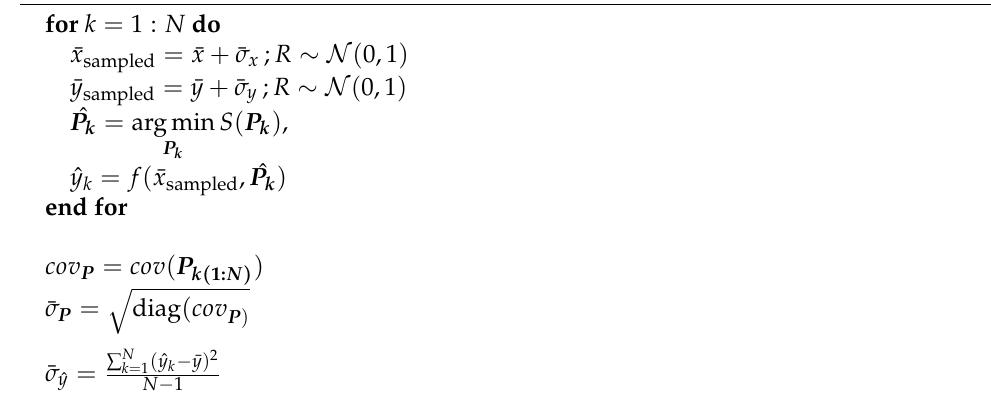
Algorithm 2 Monte Carlo sampling for regression analysis.